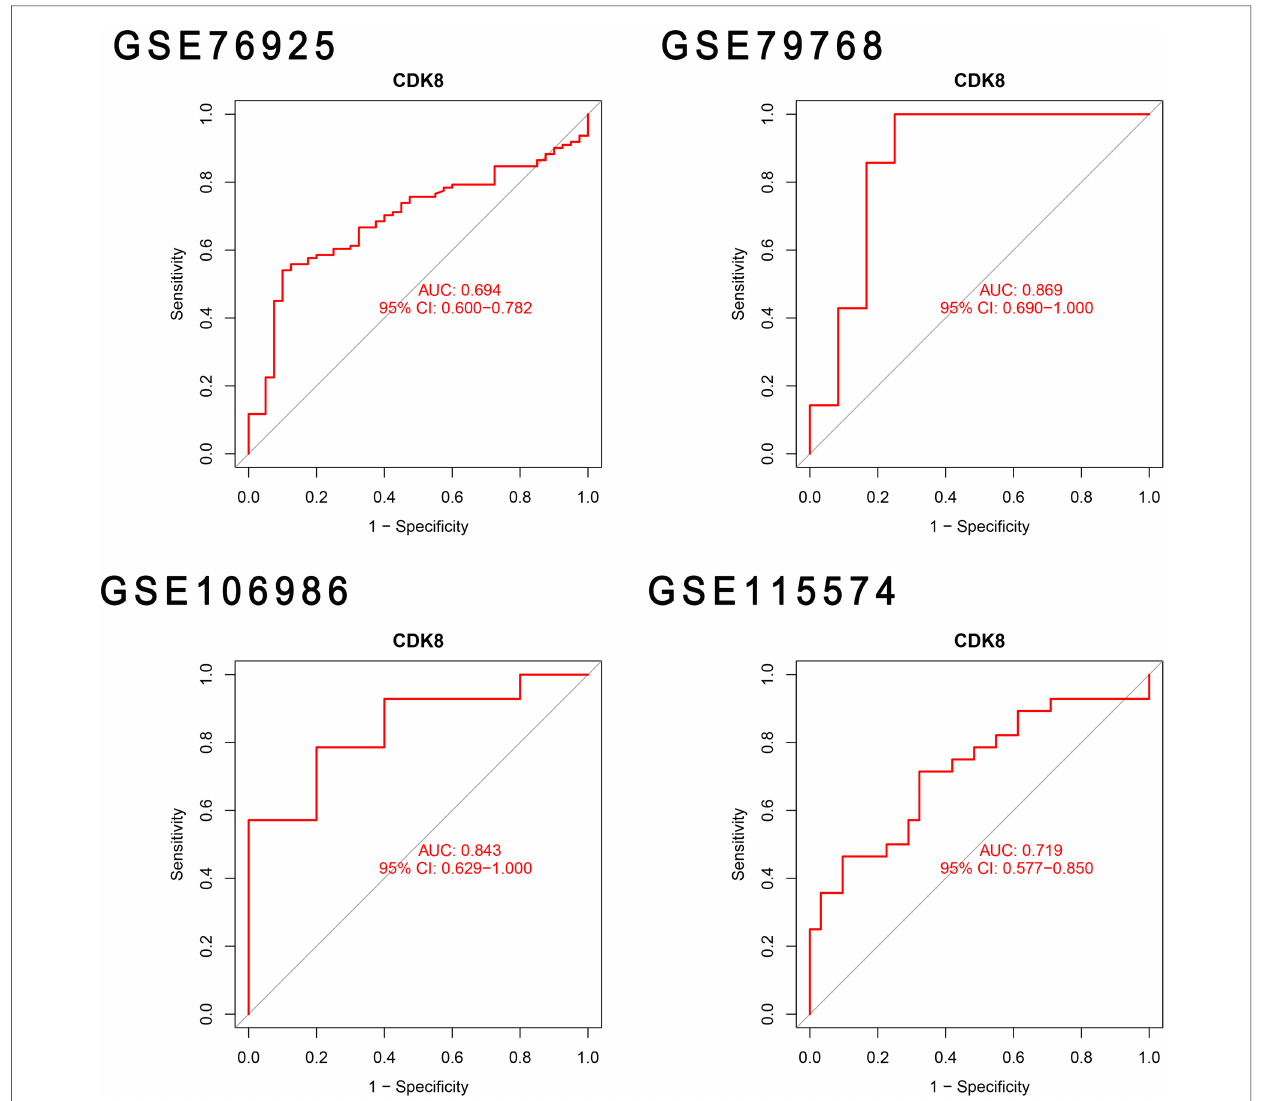
FIGURE 6 Validation hub genes are used as marker